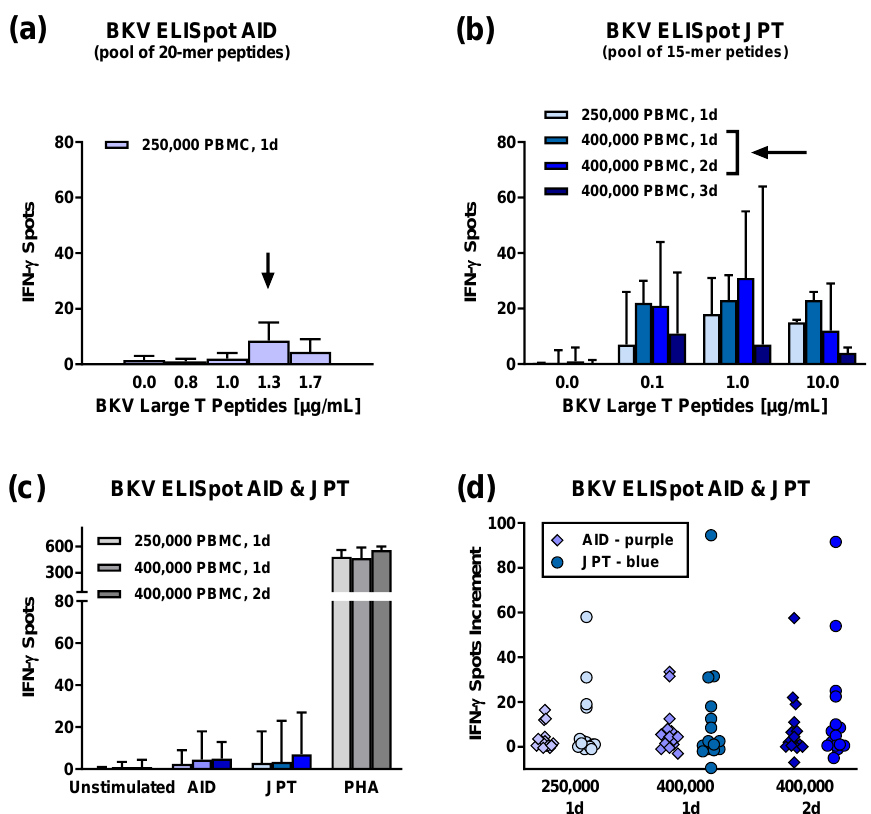
Figure A1. Optimization of ELISpot conditions to determine specific cellular immunity against BK virus (BKV) in patients after hematopoietic stem cell transplantation. Panel ( a ) shows the titration of 20 mer peptides of BKV large T (AID), using 250,000 peripheral blood mononuclear cells (PBMCs) in 1-day cell cultures ( n = 2); panel ( b ) shows the titration of a 15 mer peptide of BKV large T (JPT) with 250,000 to 400,000 PBMCs in 1–3-day cell cultures ( n = 3); and panel ( c ) shows data from 250,000 and 400,000 PBMCs and various culture durations with both BKV peptides used at optimal concen- trations (1.3 and 1 µg/mL per peptide, respectively, indicated by an arrow) ( n = 15). Each left column indicates data on 250,000 PBMCs and 1-day cell cultures, each middle column on 400,000 PBMCs and 1-day cell cultures, and each right column on 400,000 PBMCs and 2-day cell cultures. The graphs ( a – c ) show the median and 75% percentile. Panel ( d ) is based on the data as displayed in panel ( c ). It indicates individual values, given as spots increment, i.e., response towards BK virus (BKV) large T peptides (from AID or JPT) minus unstimulated controls ( n = 15). PHA, phytohemagglutinin (pos- itive control). In panel ( c ) and ( d ) the brightest color (either grey, blue or purple) indicates 250,000 PBMC and 1d culture, the intermediate color 400,000 PBMC and 1d culture and the darkest color 400,000 PBMC and 2d culture.